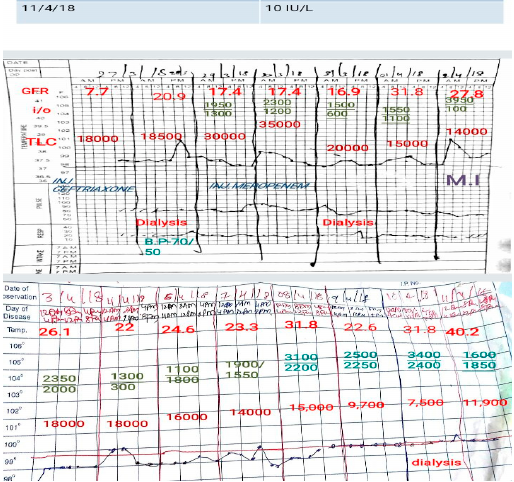
Figure 5. Illustrates the graphical representation of her illness during her stay in the hospital.